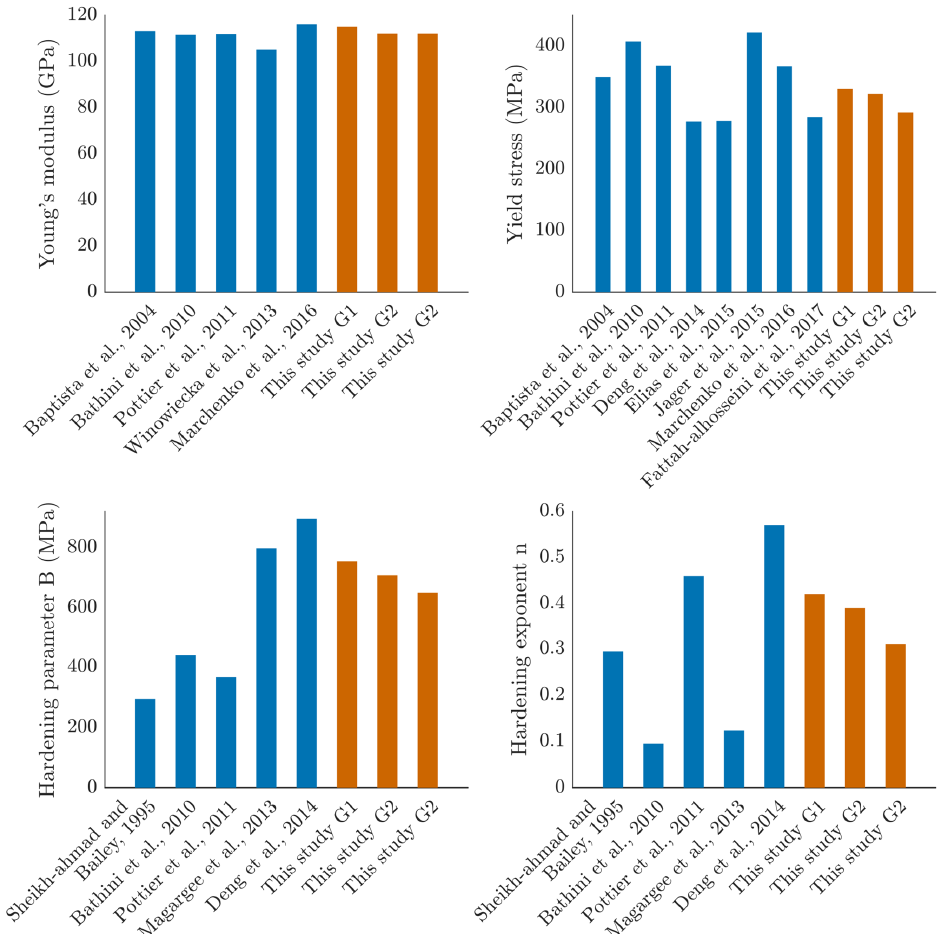
Figure 10. Comparison to the literature of the identified parameters ( a ) E the Young’s modulus, ( b ) σ y the yield stress, ( c ) B the hardening parameter, ( d ) n the hardening